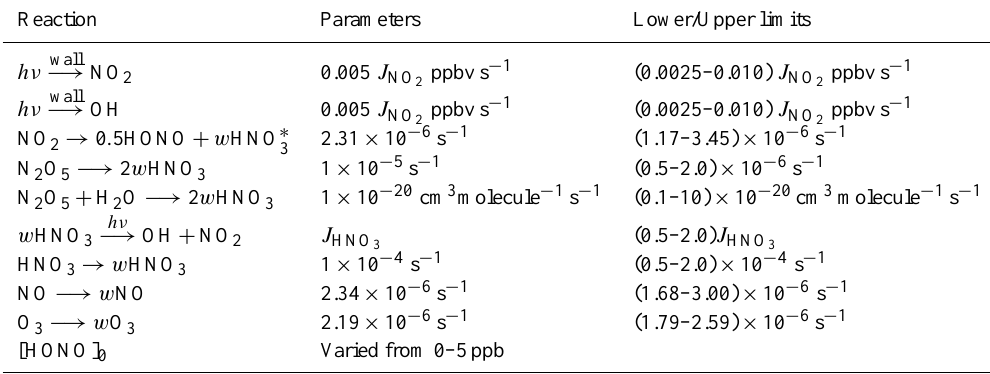
Table 5. Auxiliary mechanisms for chamber-dependent reactions.